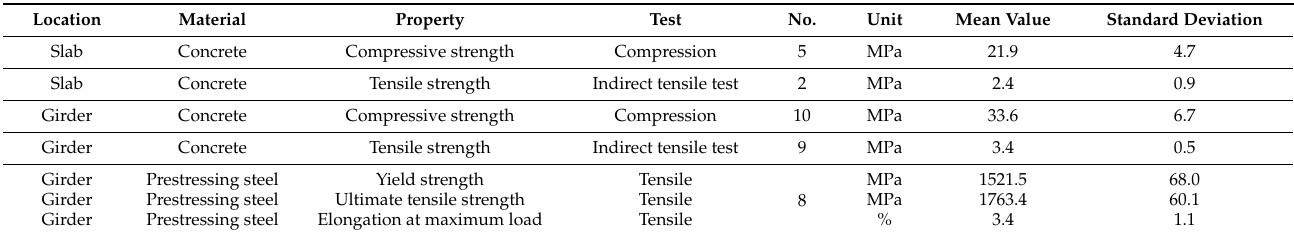
Table 2. Material properties of the destructive